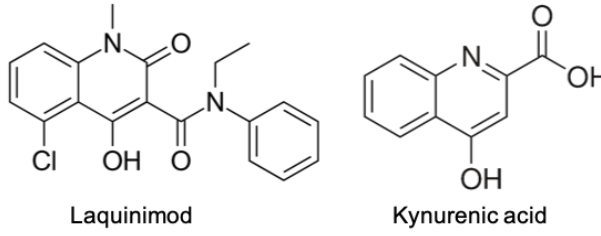
Figure 2. The chemical structure of laquinimod and kynurenic acid.